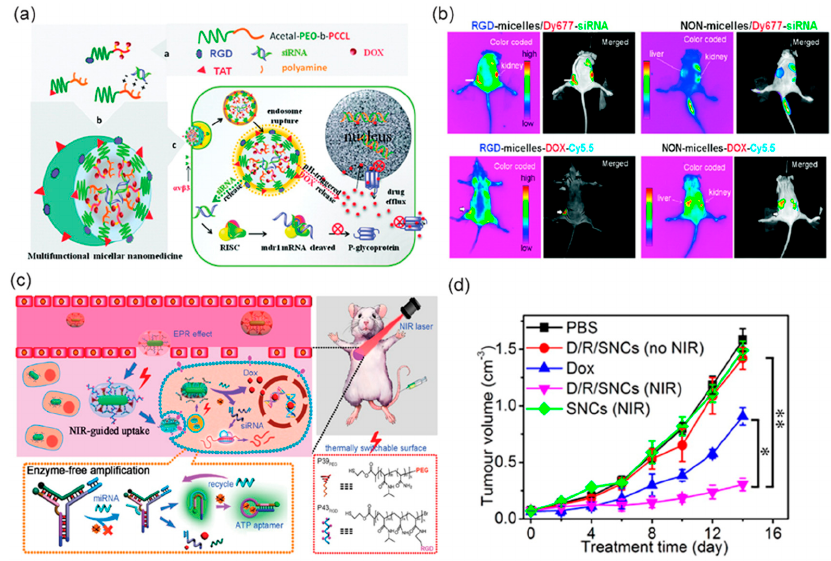
Figure 5. ( a ) Schematic diagram of multifunctional micellar nanoparticles for targeted co-delivery of siRNA against P-gp and DOX designed to overcome multidrug resistance. Drugs are encapsulated at the micellar core and the shell of the micelles are modified with RGD or TAT peptides. ( b ) In vivo near-infrared fluorescent imaging of athymic nude mice bearing MDA-MB-435/LCC6MDR1-resistant tumors upon intravenous administration with RGD- and NON-micelles-DOX-Cy5.5 and RGD- and NON-micelles/Dy677-siRNA. Reprinted (adapted) with permission from reference [106], Copyright © 2011 American Chemical Society. ( c ) Schematic illustration of smart nanocarriers (SNC) capable of NIR-mediated siRNA and DOX co-delivery with endogenous miRNA and ATP as the controllers of intracellular cargo release. ( d ) Tumor growth inhibition efficacy of the SNCs in mice bearing subcutaneous HeLa tumors. * p < 0.05, ** p < 0.01 (two tailed Student’s t-test). Reprinted (adapted) with permission from reference [109], Copyright © 2011 American Chemical Society.